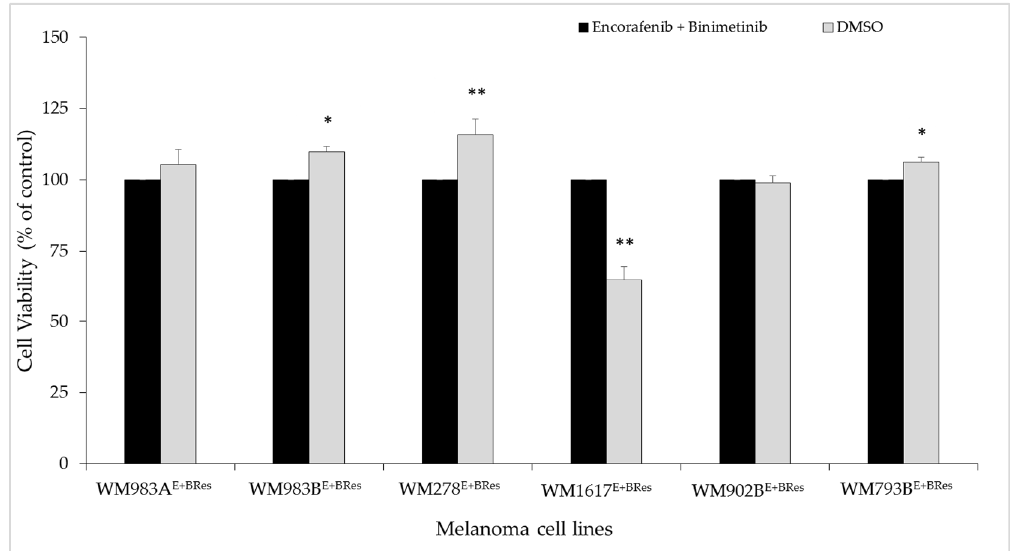
Figure 5. Effect of drug withdrawal on the viability of BRAFi/MEKi-resistant melanoma cell lines. The viability of the resistant cells after drug withdrawal (ENCO+BINI were removed, and DMSO was added for 72 h to the cell cultures: grey columns) was compared with that of cells that were treated continuously with the drugs (cells grown in the presence of 200 nM ENCO+BINI: black columns). The data are presented as the mean ± SD of three independent experiments. The asterisk indicates a statistically significant difference (Mann–Whitney–Wilcoxon test; * p < 0.05, ** p < 0.001).